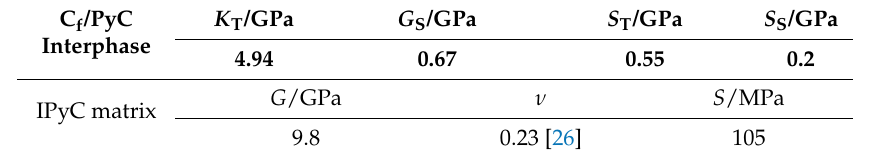
Table 1. The mechanical properties of the C f /PyC interphase ( L a = 3 nm) and the IPyC matrix.